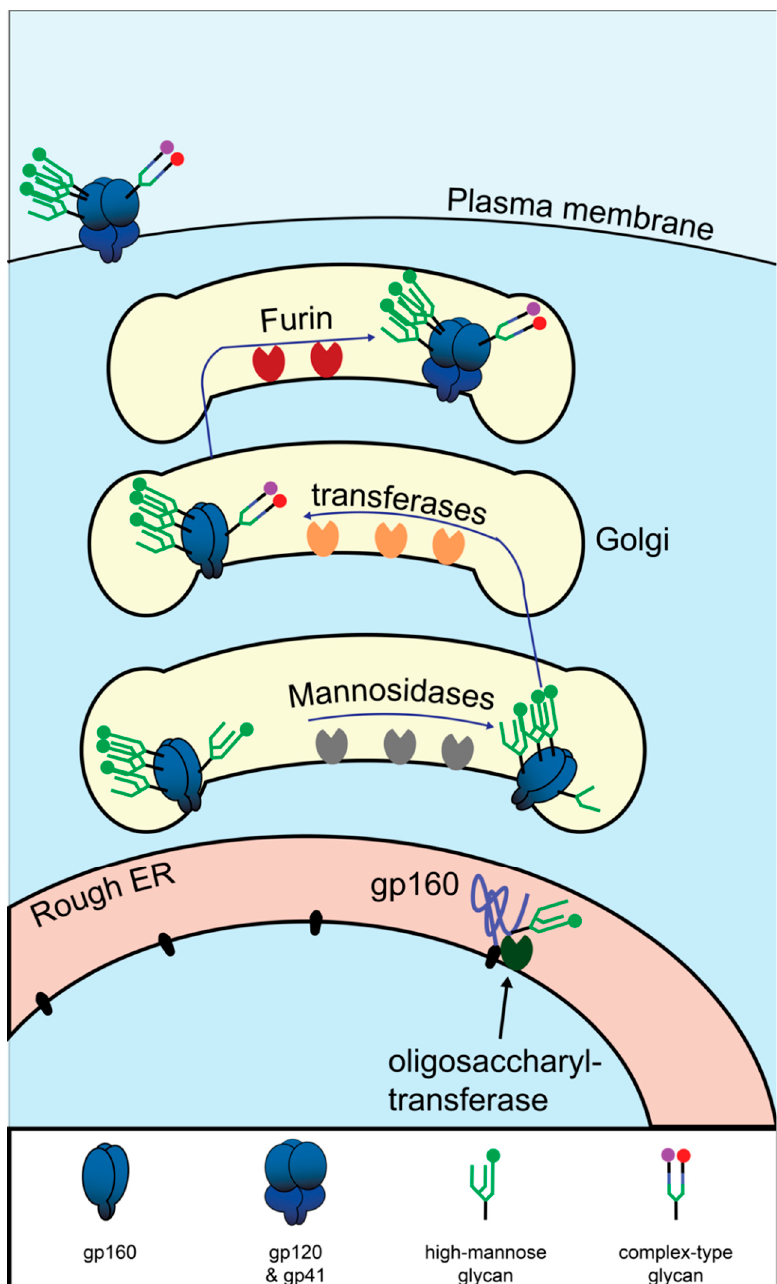
Figure 3. Biosynthesis HIV Env in the secretory pathway. Graphical depiction of translation and glycosylation of Env in the endoplasmic reticulum, followed by post-translational modifications in the Golgi. Mannose oligomers are depicted in green. The mannose patch is depicted as three densely packed glycans. For a detailed depiction of the monomers composing the glycans, see Figure 4.